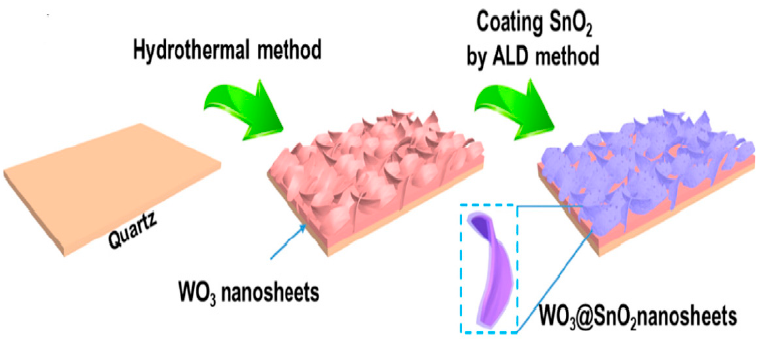
Figure 8. ( a ) Structural diagram of the micro-hotplate; ( b , c ) ZnO nanowires synthesized by hydrothermal method; ( d , e ) locally synthesized ZnO nanowires replaced by SnO 2 nanotubes (PH = 4) by liquid deposition method or SnO 2 /ZnO composite structure (PH = 6) [64].